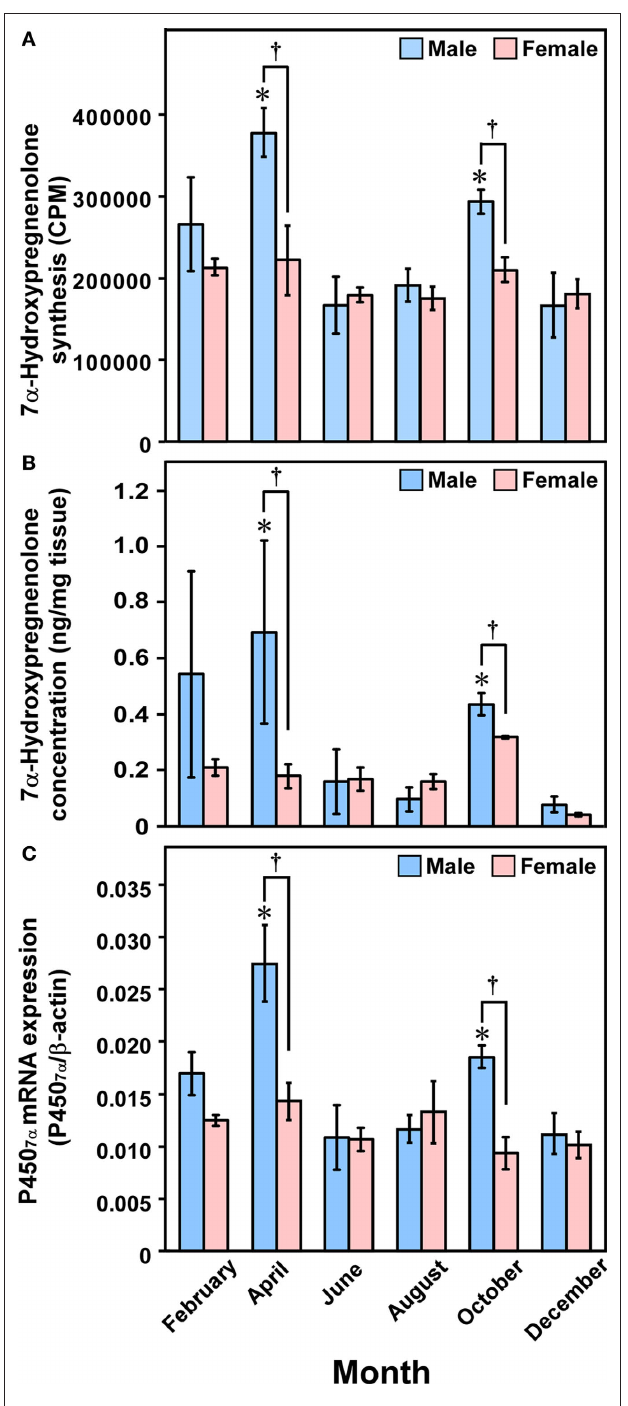
FigurE 7 | Seasonal changes in 7 α -hydroxypregnenolone synthesis and concentration, and P450 mrNA expression in the newt brain. 7 α (A) Seasonal changes in 7 α -hydroxypregnenolone synthesis in the brain. (B) Seasonal changes in 7 α -hydroxypregnenolone concentration in the brain. (C) Seasonal changes in P450 mRNA expression in the brain. Each column 7 α and vertical line represents the mean ± SEM ( n = 6). * p < 0.05 vs. December; † p < 0.05 male vs. female by two-way ANOVA, followed by Tukey–Kramer test. Adapted from Haraguchi et al.